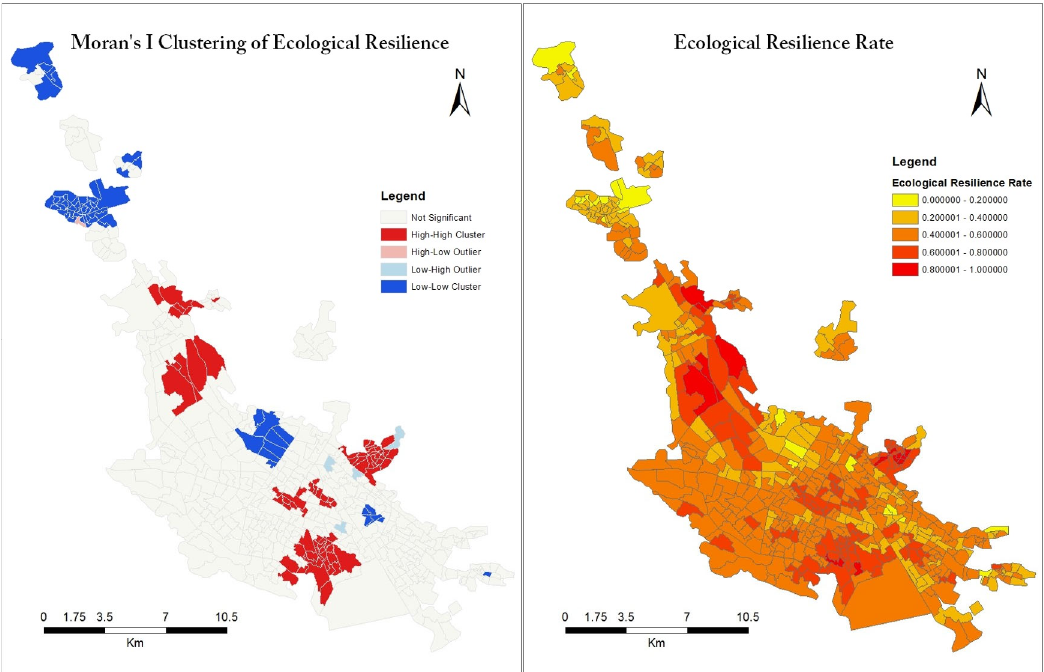
Figure 3. Ecological urban resilience value distribution in the case of Shiraz.